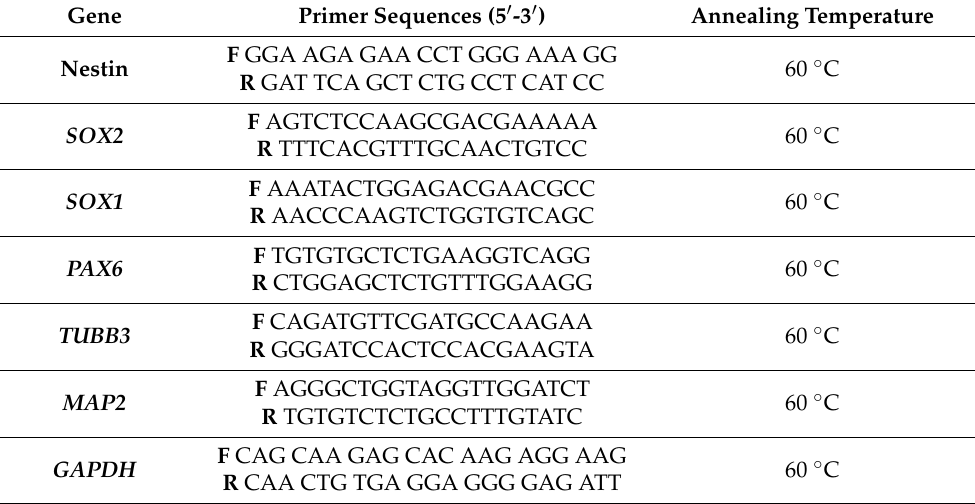
Table 2. List of RT-qPCR primers used for the detection of the differentiation step markers. Gene Primer Sequences (5 (cid:48) -3 (cid:48)